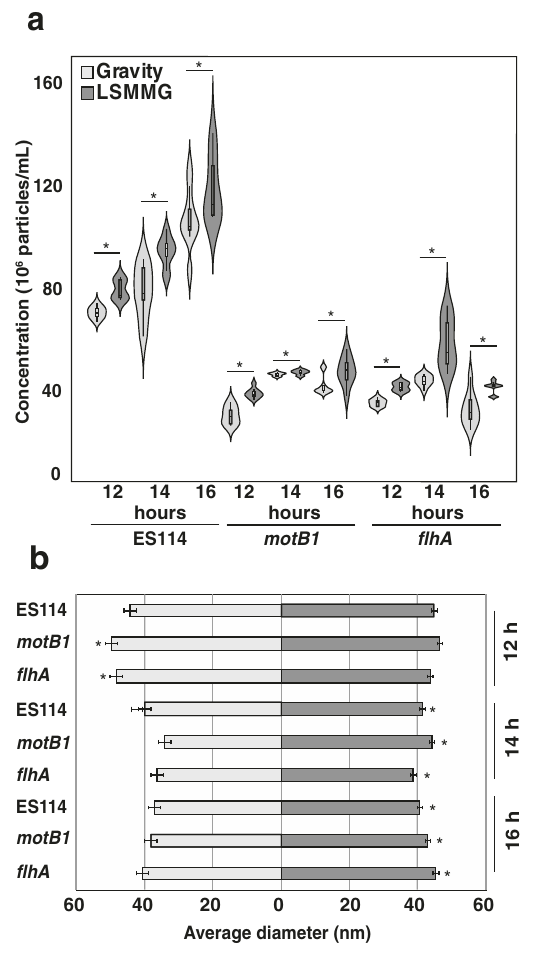
Fig. 4 Nanoparticle size analysis of outer-membrane vesicles (OMVs) isolated from Vibrio fi scheri . a Concentrations of OMVs in V. fi scheri wild-type (ES114) and motility mutants ( motB1 and fl hA) under gravity (light gray) and low-shear modeled microgravity (LSMMG, dark gray) conditions. b Average diameter of OMVs at 12, 14, and 16 h of incubation under gravity (light gray) and LSMMG (dark gray) conditions. Error bars indicate the standard error of the mean. Asterisks indicate signi fi cant differences between the data sets ( p < 0.05; Mann – Whitney U